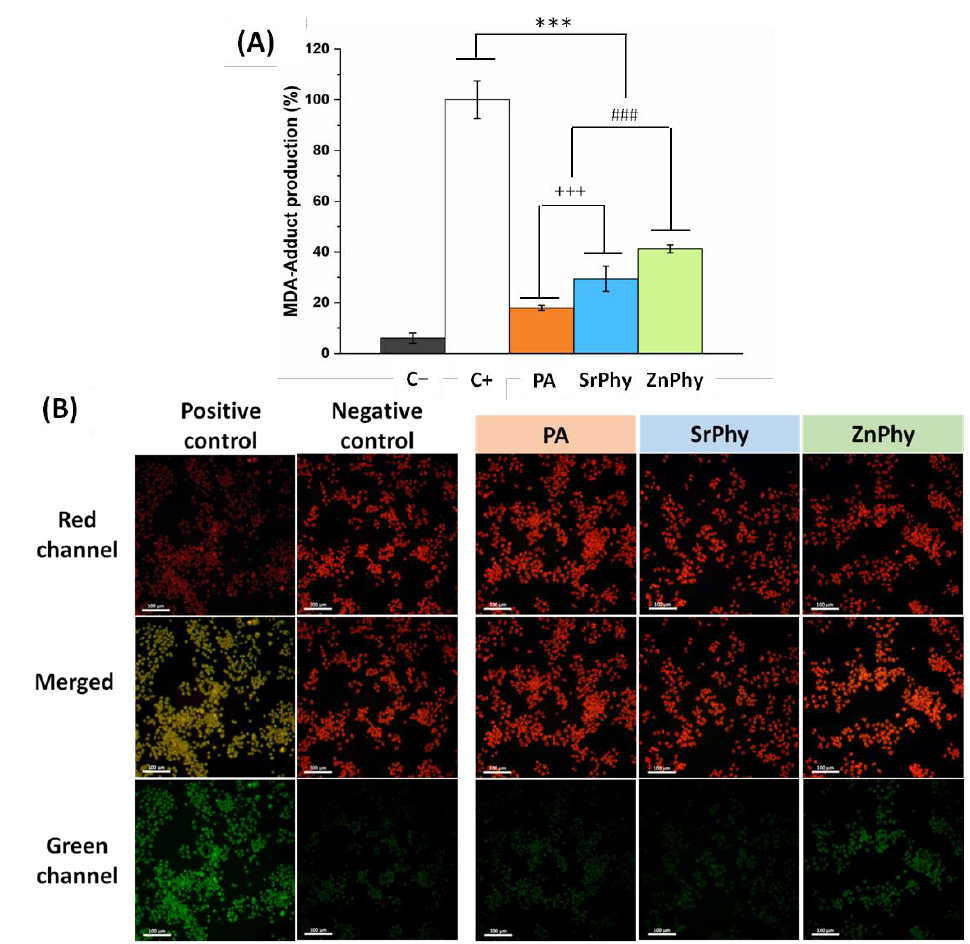
Figure 5. ( A ) Quantitative assessment of the MDA production as determined with an ELISA test with RAW264.7 cultures. The positive control corresponds to activated macrophages (Fe 2 SO 4 · 7H 2 O/H 2 O 2 treatment). Statistical differences were evaluated at the significance levels *** p < 0.001 relative to the positive control, ### p < 0.001 for ZnPhy relative to PA and SrPhy, and +++ p < 0.001 between PA and SrPhy (Tukey’s test). ( B ) Qualitative determination of lipid peroxidation using fluorescence imaging. Green fluorescence corresponds to activated cells (positive control) and the red signal was emitted by non-treated cells (negative control). Scale bars correspond to 100 µm. Results were presented as the mean value (%) ± SD ( n = 2).